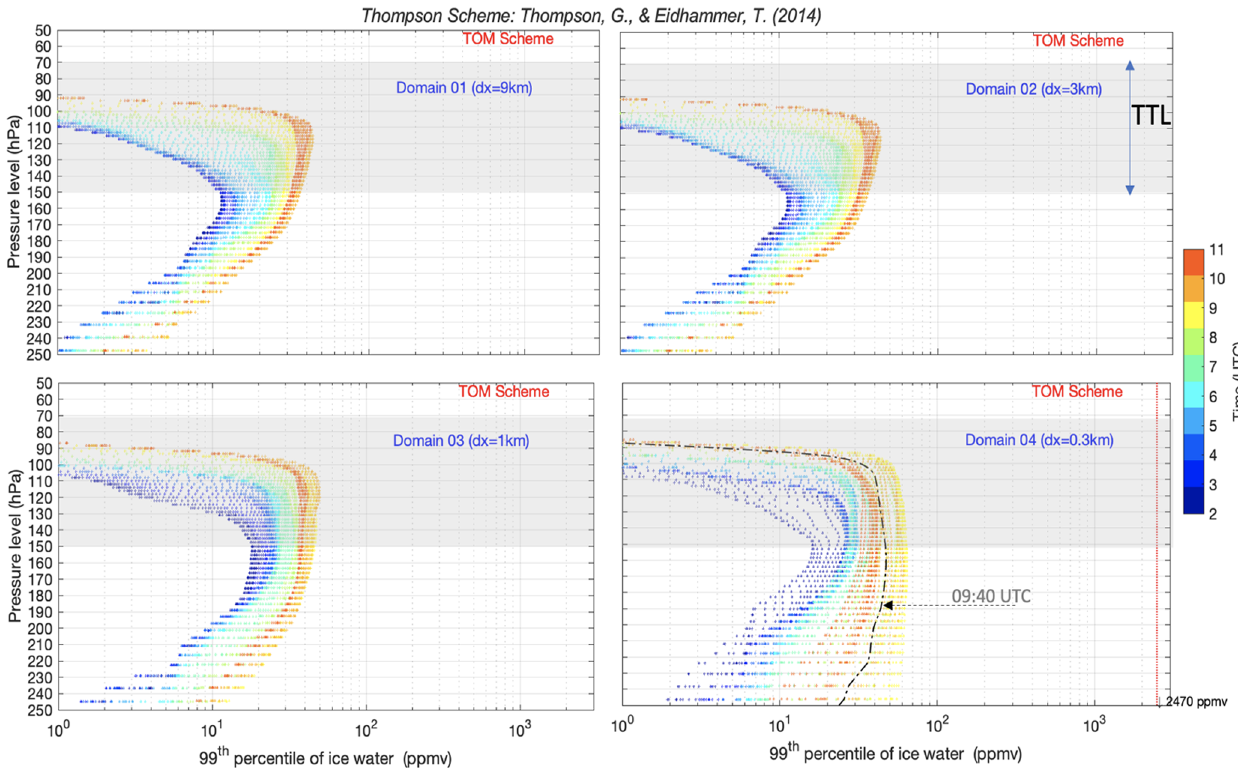
Figure A1. Profile of 99th percentile of simulated IWC below and within the TTL (gray shade) using the Thompson microphysics scheme, with a grid spacing of 9km (upper left), 3km (upper right), 1km (lower left), and 0.3km (lower right) color coded by time (UTC) from 02:00 to 11:00UTC. The dashed–dotted black line (lower right) represents the simulated profile at 09:40UTC (timing of the first captured peak of IWC by aircraft), and the vertical dotted red line represents the observed